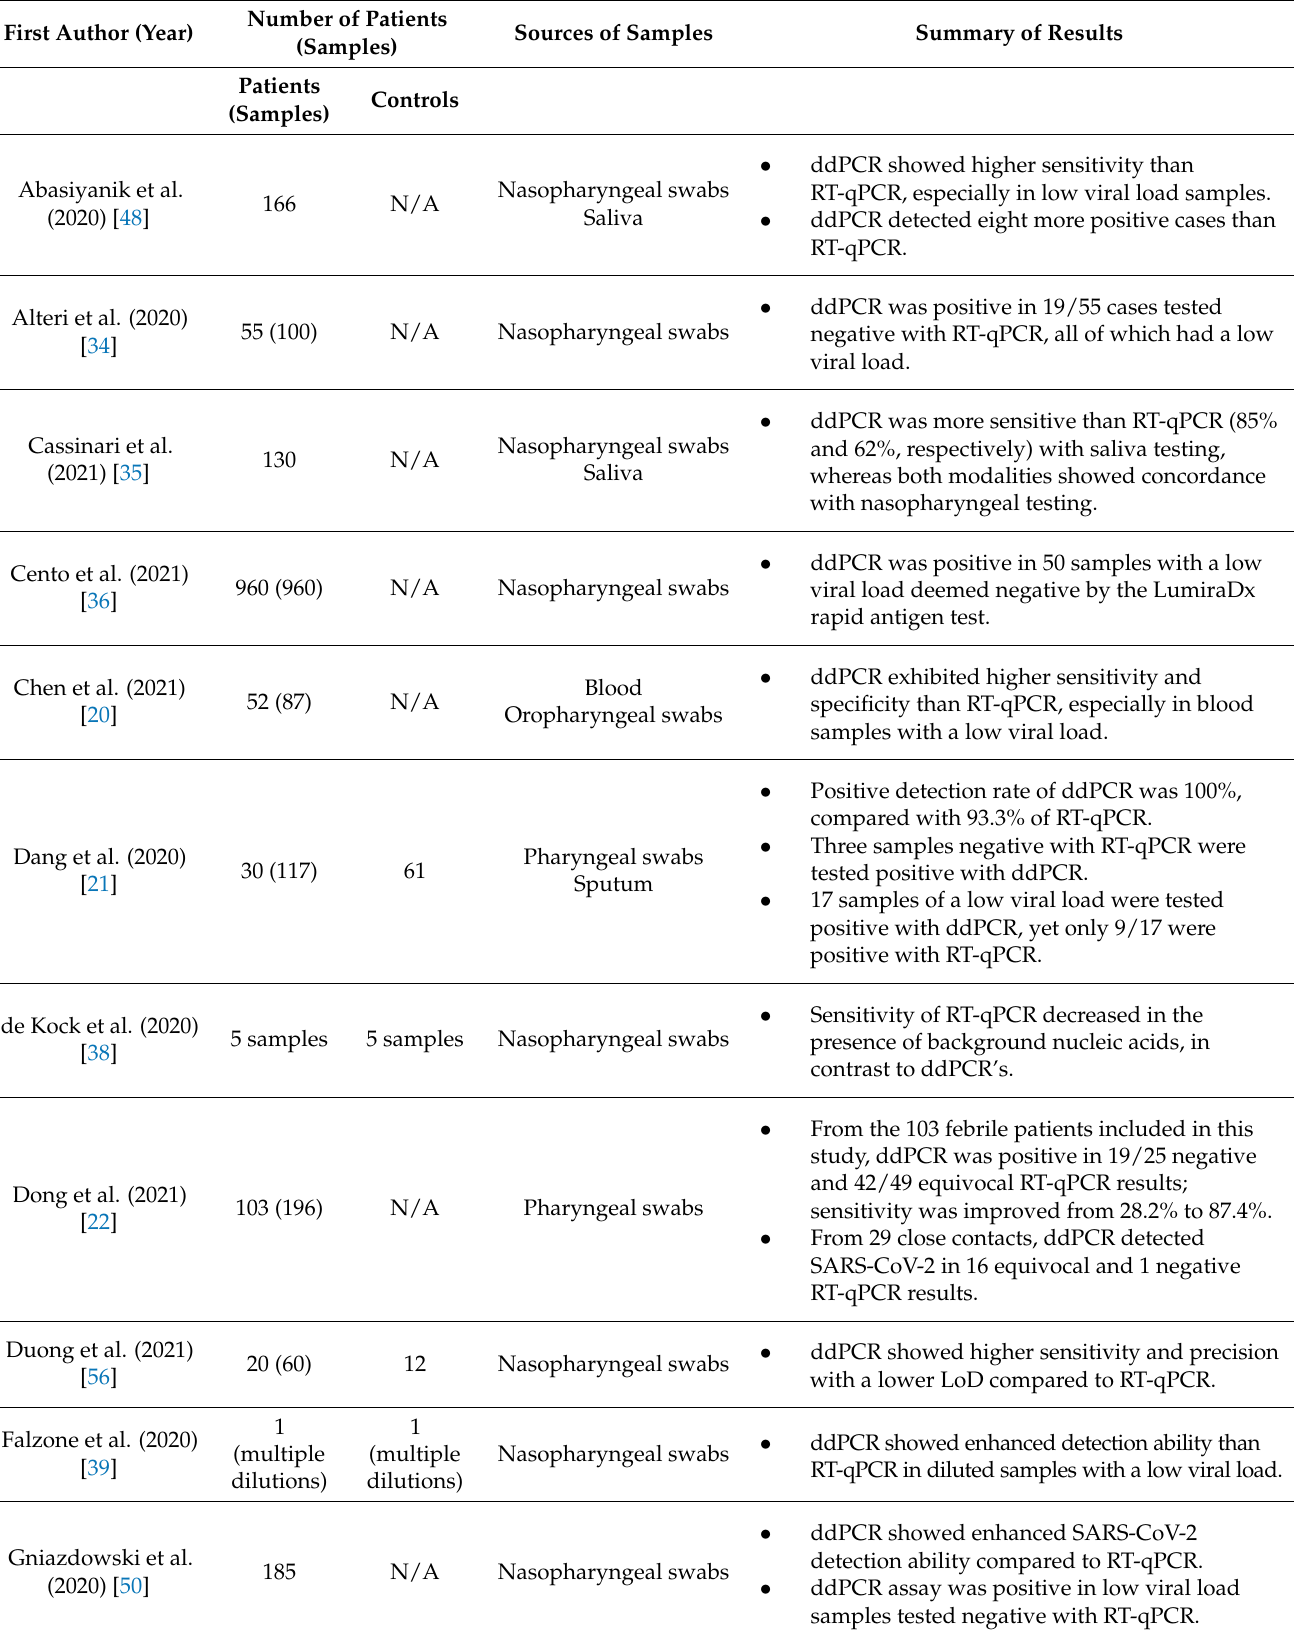
Table 1. Diagnostic performance of droplet digital PCR (ddPCR) compared to traditional testing methods in the in- cluded